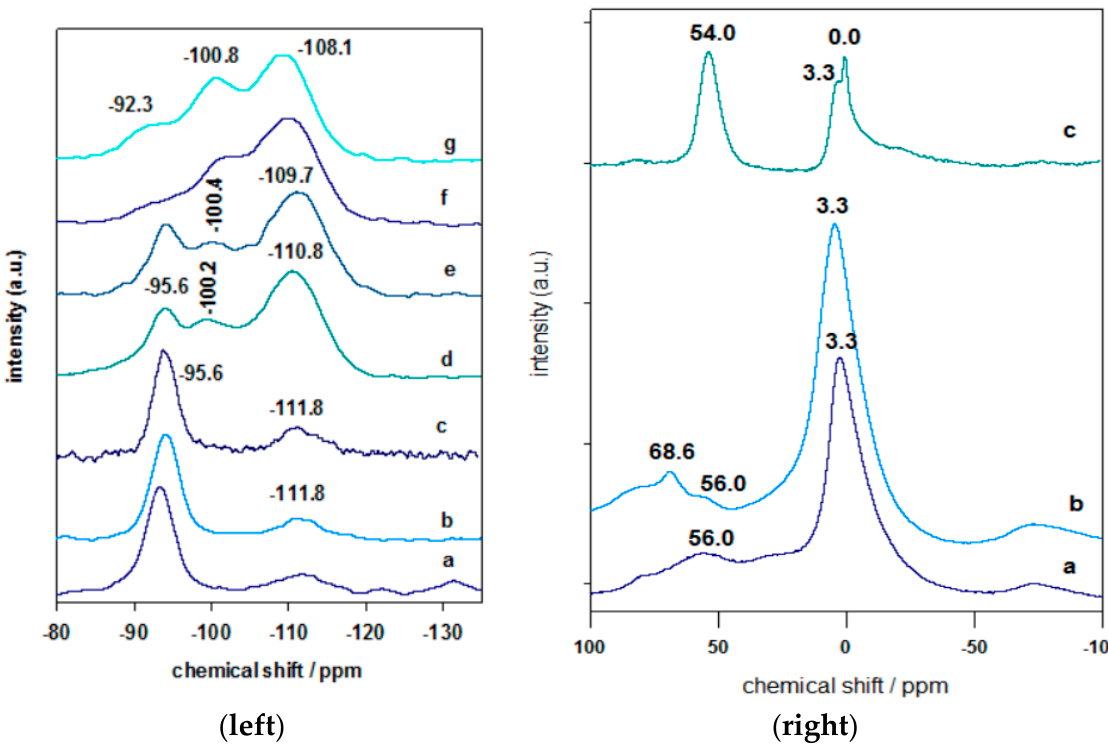
Figure 6. ( left ) Solid 29 Si NMR spectra of ( a ) Ca-Mt starting material, ( b ) Al-Mt, and ( c ) Mt-Zr. ( d ) Al-PCH, and ( e ) Zr-PCH precursors. ( f ) and ( g ) correspond to Al-PCH and Zr-PCH after calcination at 550 ◦ C. ( right ) Solid 27 Al NMR spectra of ( a ) Ca-Mt starting material, ( b ) Al-Mt, and ( c ) Al-PCH material after calcination at 550 ◦ C.